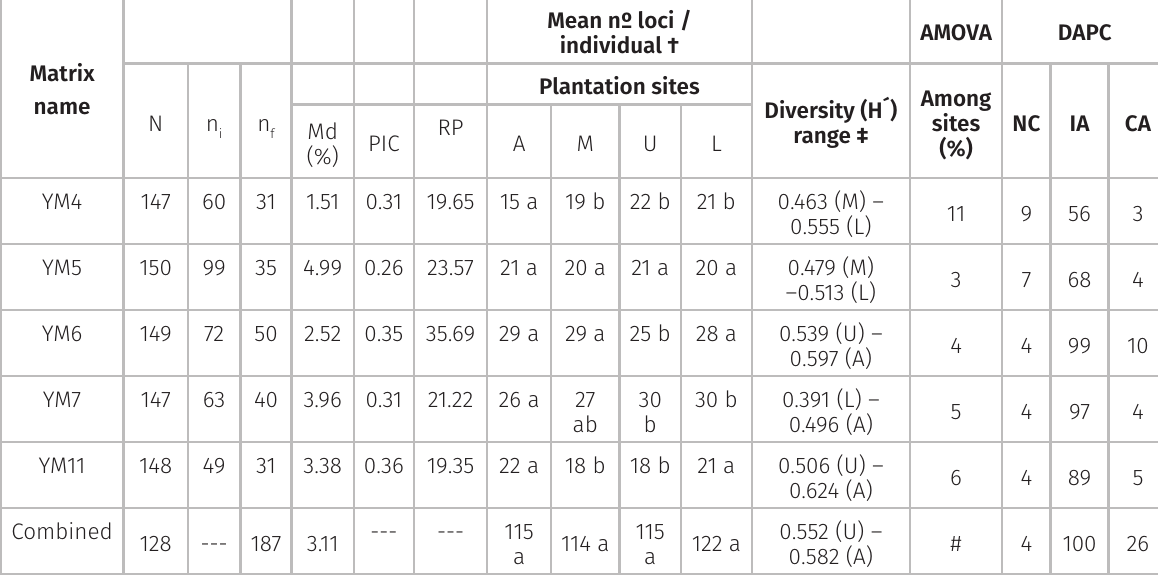
Table II. ISSR characterization of “yerba mate” cultivated plants.